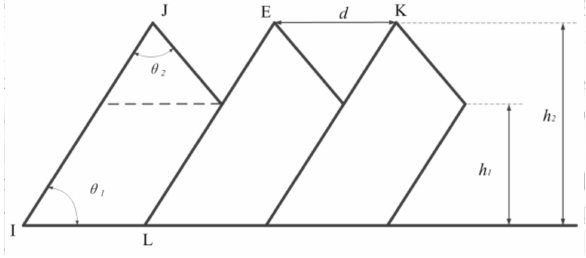
Figure 3. Geometric parameters of the saw-tooth